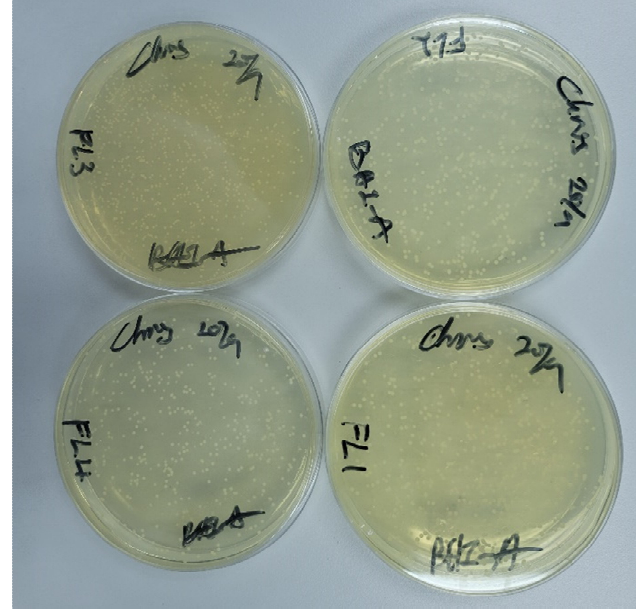
Figure 5. Supernatant of C. Albicans suspension cultured on plate. Cell colony numbers were counted on the colony counter, and the number of colony- forming units per mL (CFU/mL) was calculated using the formula below to quantify the fungus